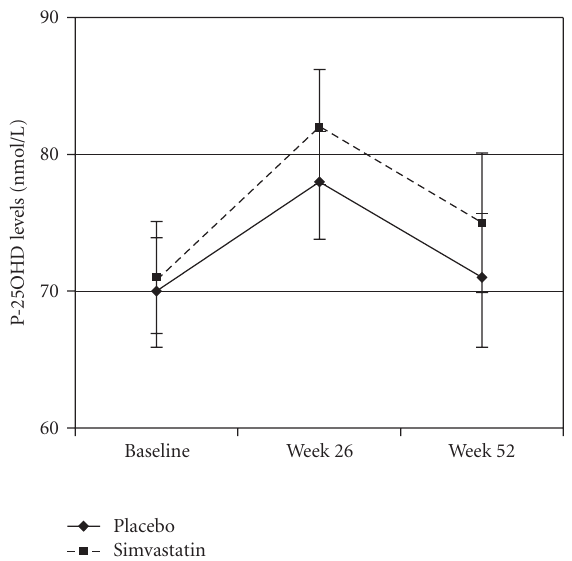
Figure 1: Changes in plasma 25-hydroxyvitamin D (P-25OHD) levels by treatment group (mean ±